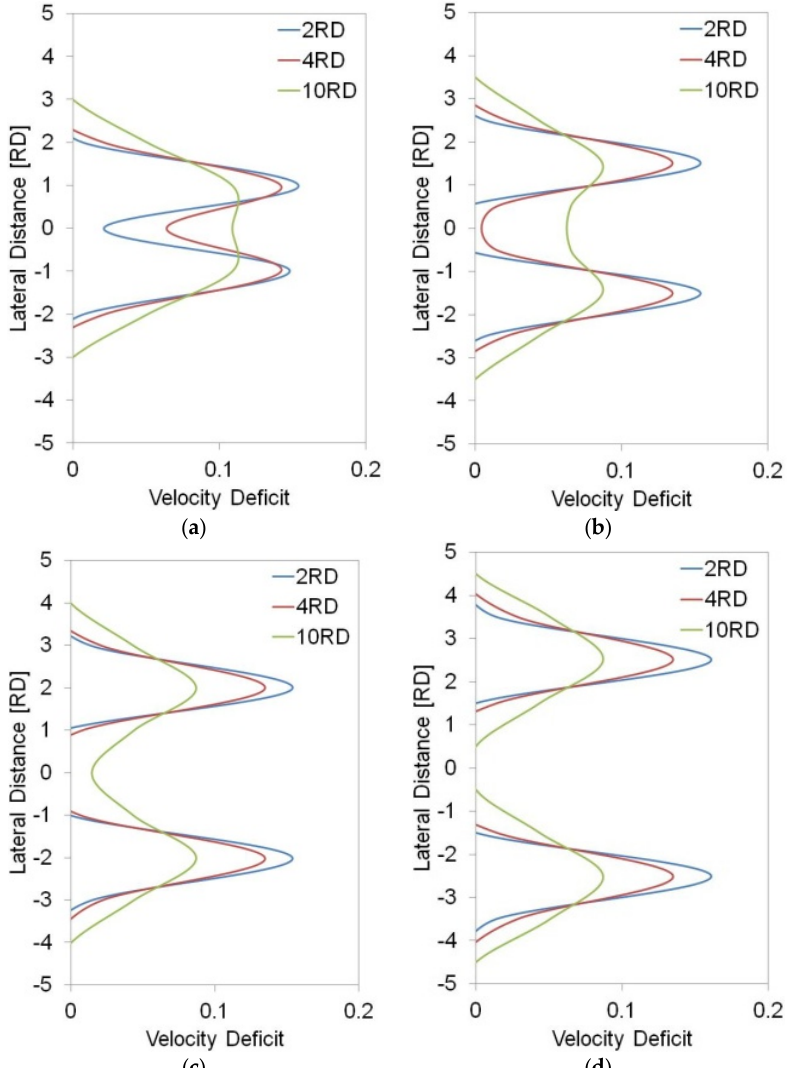
Figure 10. Changes in current speeds for two turbines deployed at ( a ) 1 RD and ( b ) 10 RD lateral spacing.